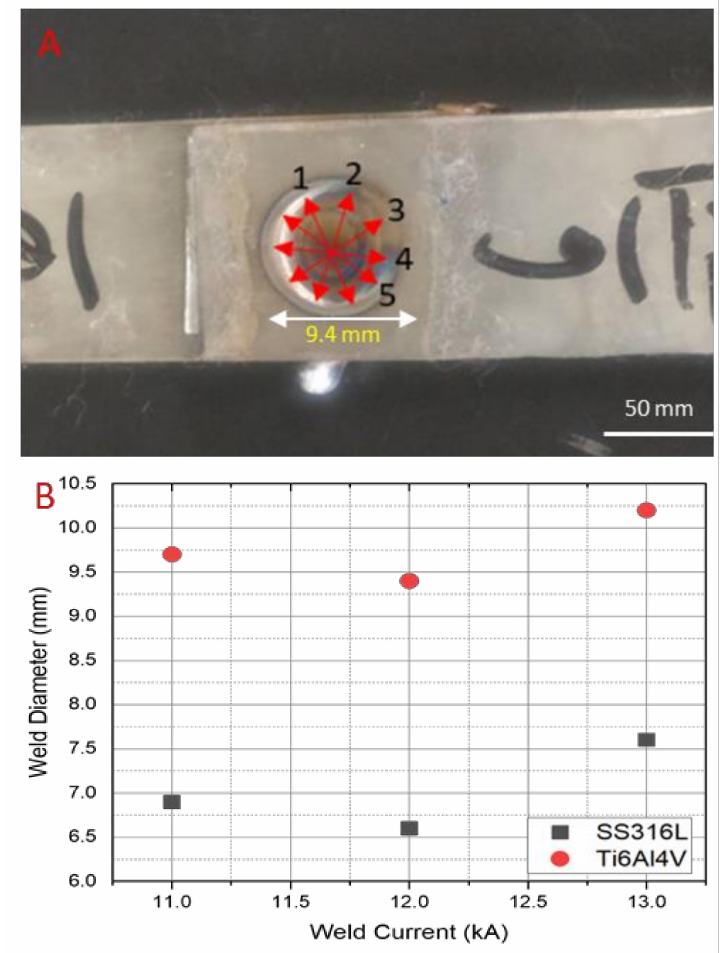
Figure 4. Weld diameter measurements: ( A ) the dispersion of the measurements; ( B ) the variance of the weld diameter measurement results from sample 1, sample 2, and sample